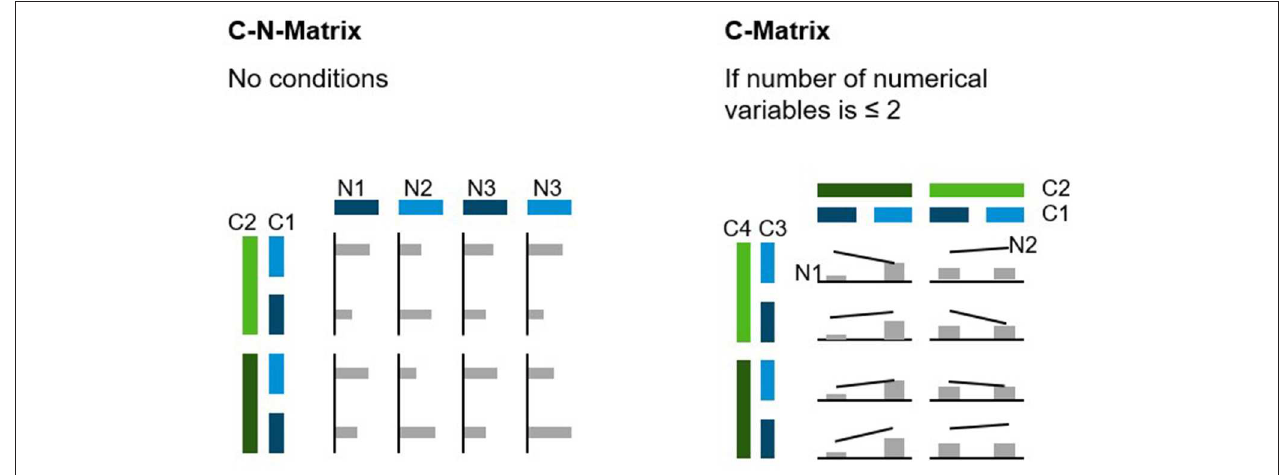
FIGURE 6 | C-N-Matrix and